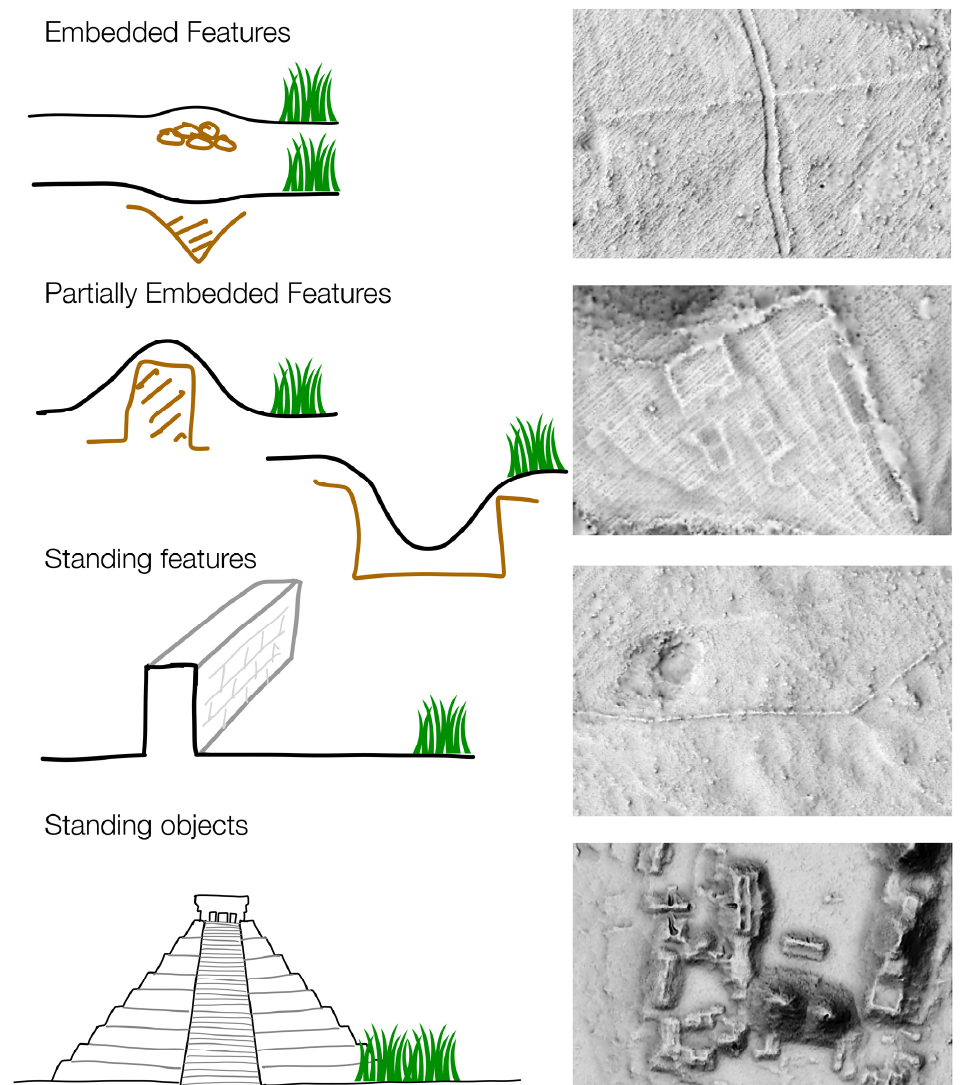
Figure 5. Morphological types of archaeological features detectable via DFM (Bottom-right figure after [22], Figure 8, CC-BY